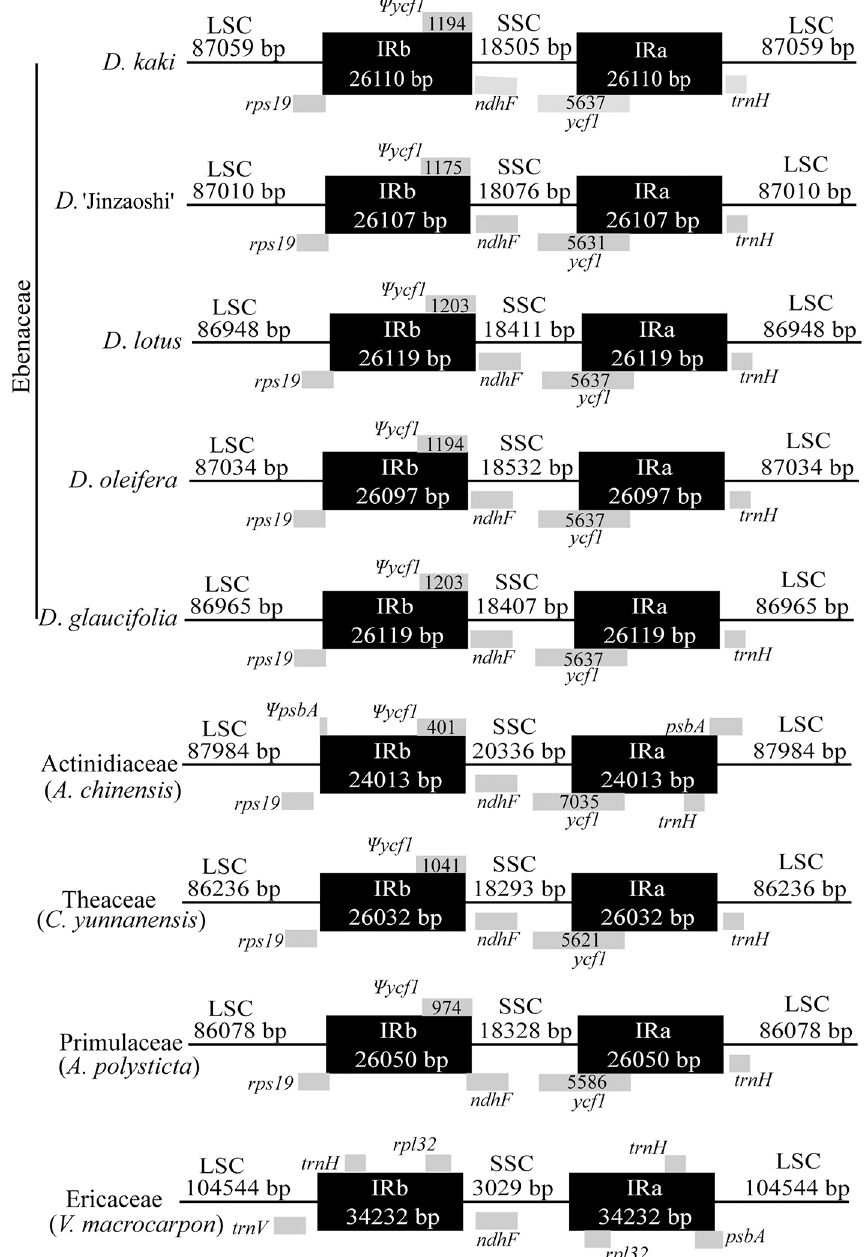
Fig 5. The comparison of inverted-repeat (IR) and single-copy (SC) borders among nine chloroplast genomes. Gene annotation or portions are represented by gray boxes above or below.